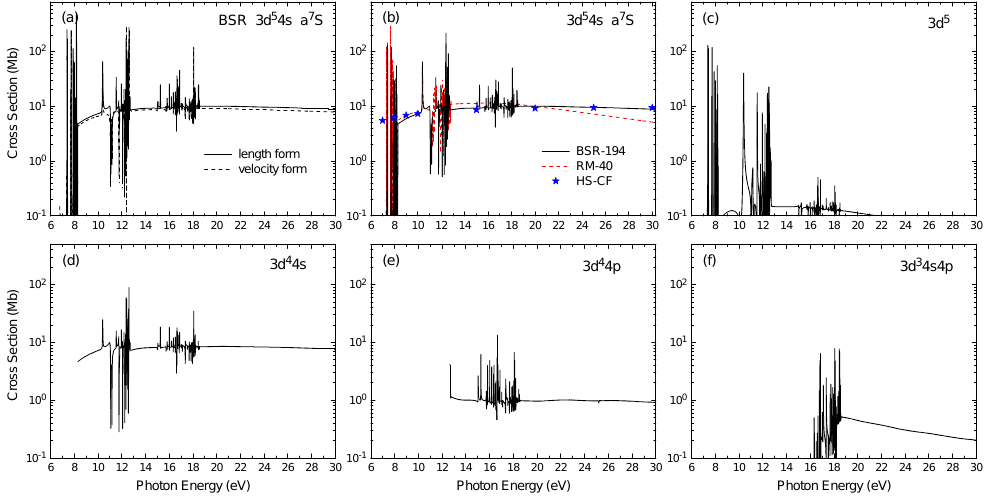
Figure 1. Total and partial photoionization cross sections from the ground 3 d 4 4 s 7 S state of Cr I as a function of photon energy. Panel ( a ) shows total cross sections from the present BSR-194 model in the length and velocity forms. Panel ( b ) compares the BSR-194 model with the RM-40 calculation of Nahar [14] and with Hartree-Slater central-field (HF-CF) calculation of Reilman and Manson [12]. Panels ( c – f ) show summed partial cross sections for leaving the residual Cr II ion in final states of the 3 d 5 , 3 d 4 4 s , 3 d 4 4 p , and 3 d 3 4 s 4 p